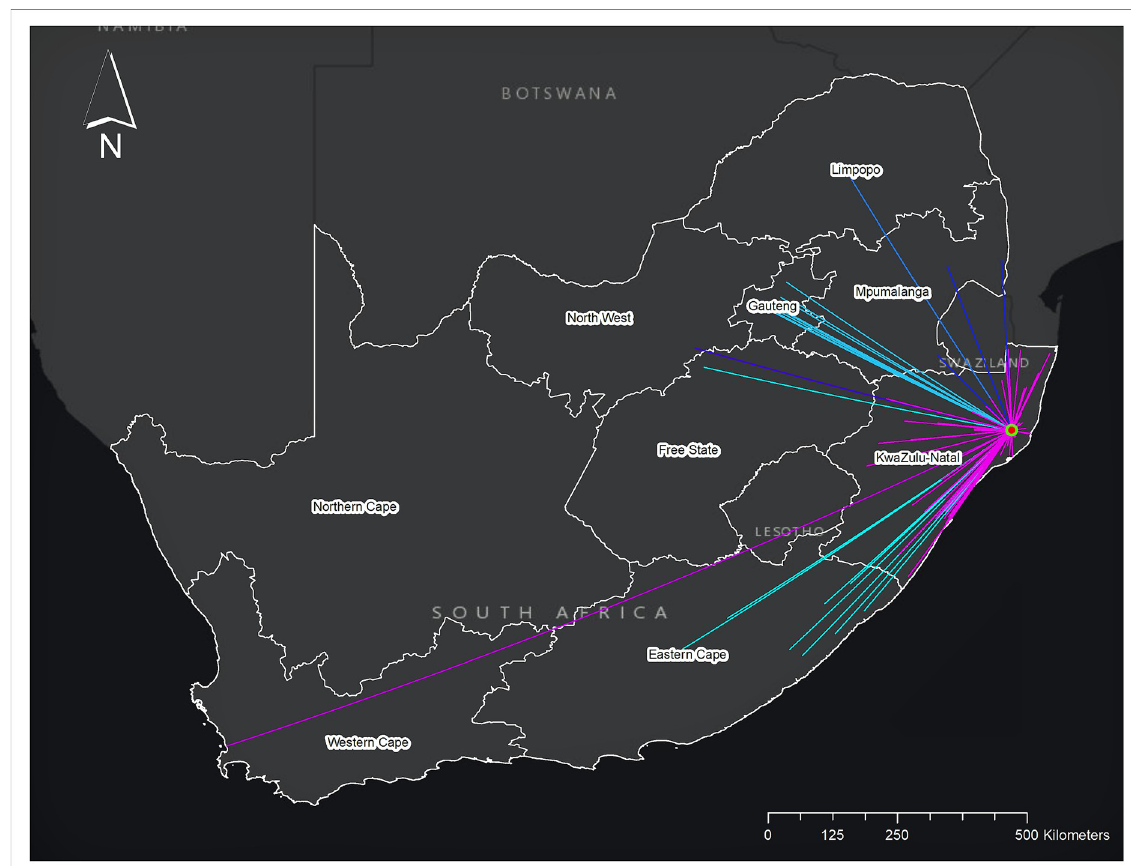
Fig 4. Linkage of female and male partners of stable sexual relationship pairs between a resident and a non-resident of the surveillance area. All links were formed by relationship pairs in which one partner was a resident within the surveillance area and the other partner was a non-resident outside the surveillance area across South Africa (n = 421). Linkage to a non-resident is represented by different colors of the states. Only approximate locations are shown in the map to protect confidentiality of